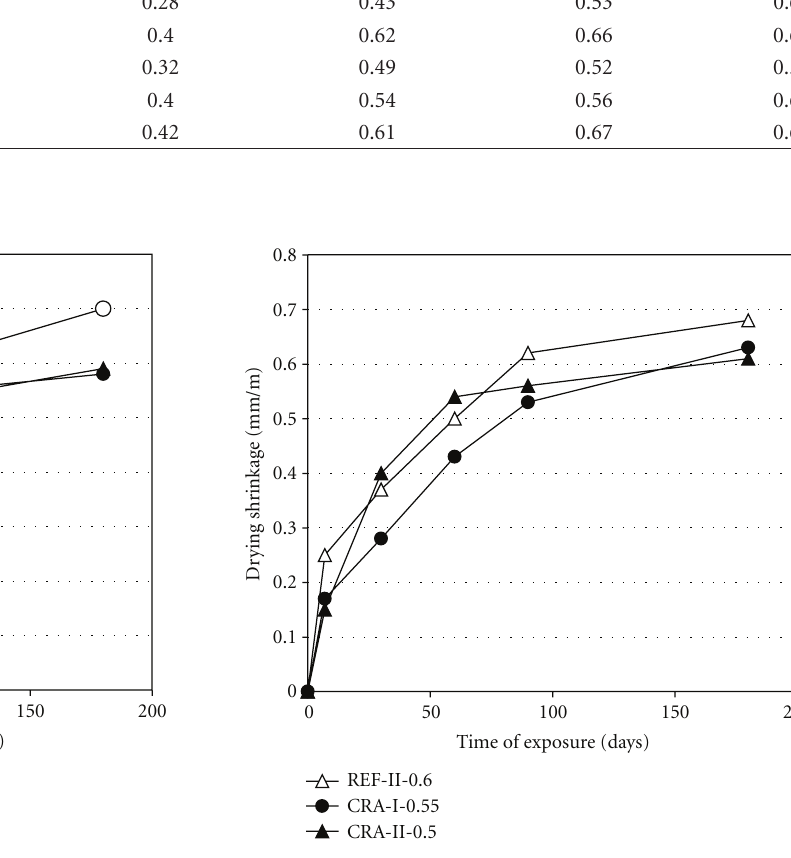
Figure 6: Drying shrinkage versus time of exposure for C 25/30 strength class